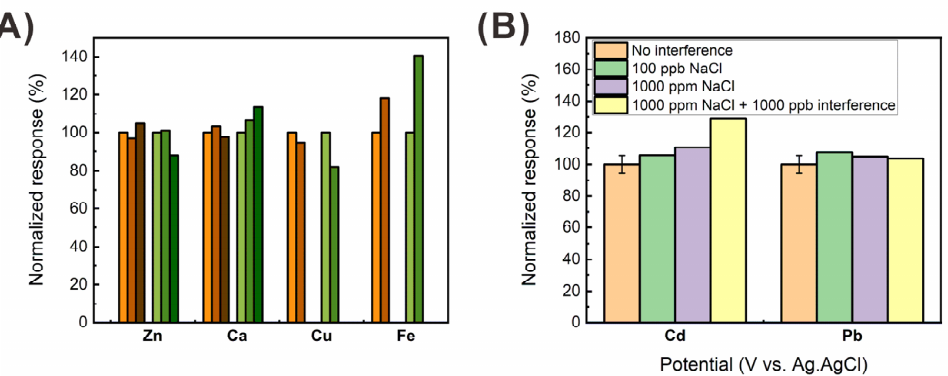
Figure 9 Figure 9. Interference effect on the heavy metal detection of the HPC-based heavy metal sensor: ( A ) normalized peak current signals of 20 ppb Cd (brown color) and Pb (green color) against metal ion interferences (Zn, Ca, Cu, and Fe) of 100 and 20 ppm; ( B ) normalized peak current signals of 20 ppb Cd (left bars) and Pb (right bars) against NaCl and NaCl with metal ion interferences (Zn, Ca, Cu, and